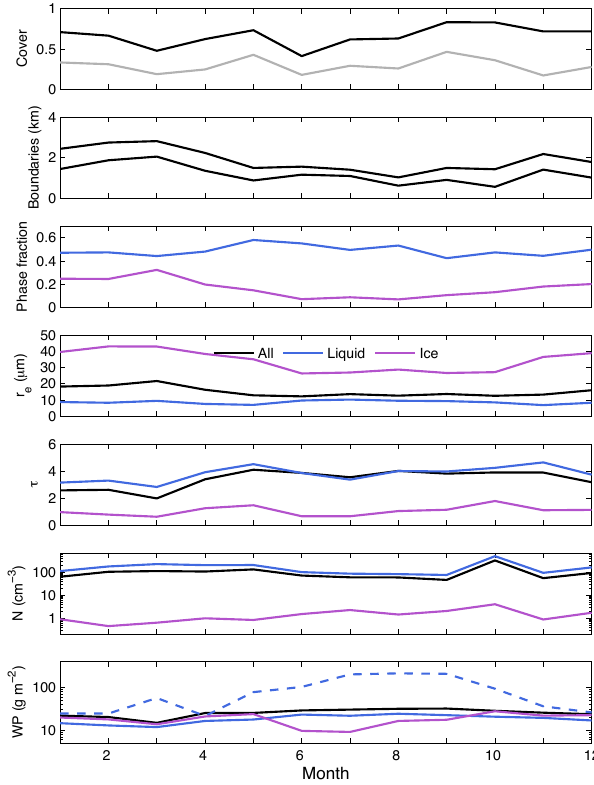
Fig. 15. Retrieved cloud boundaries H , emissivity (at 862.5cm − 1 ) and transmissivity (at 1040cm − 1 ), ratio of spectral slopes χ = (ε b /ε e )/ (cid:0) ε e /ε g (cid:1) , and cloud droplet effective radius r e , visible op- tical depth τ , particle number concentration N , and condensate wa- ter path WP, for the scene in Fig. 14 observed at NSA-AAO on 13 January 2001.